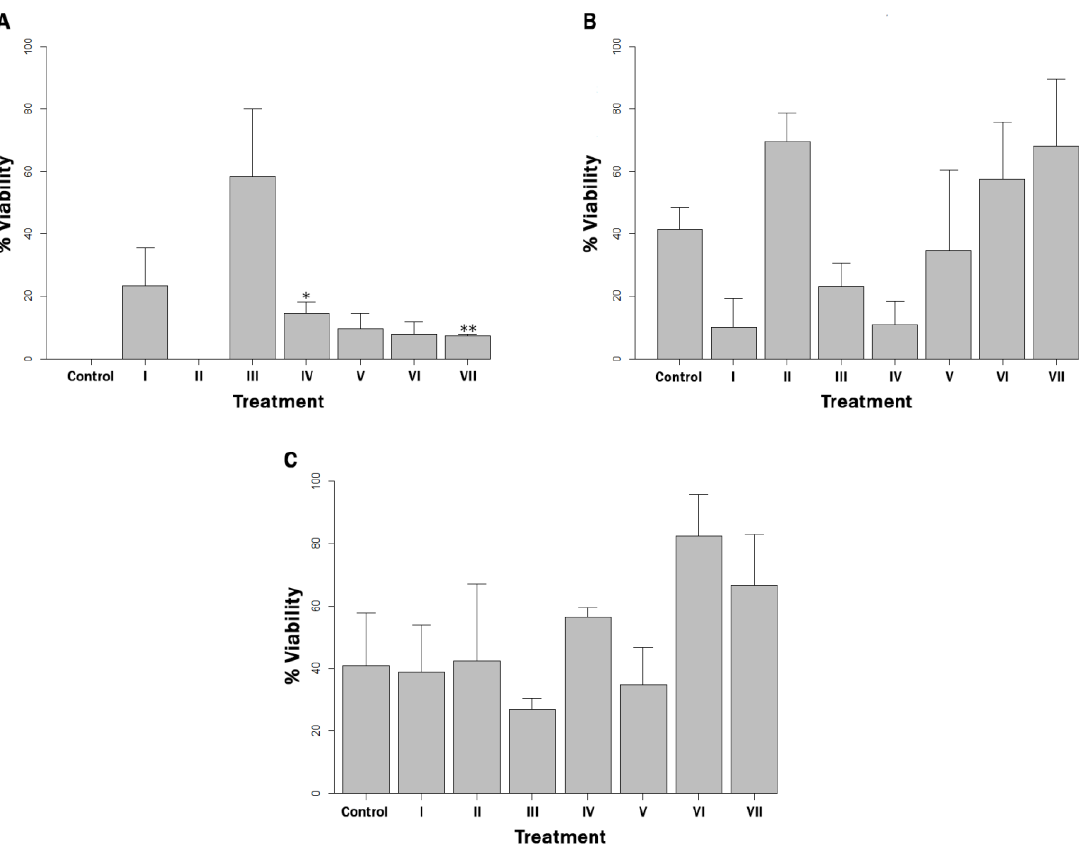
Figure 2. Percentage of protection of viable cells (% Viability) in milk artificially contaminated with: ( A ) 10 2 MAP cells mL −1 , ( B ) 10 4 MAP cells mL −1 and ( C ) 10 6 MAP cells mL −1 , and supplemented with (I) EDTA, (II) BCS, (III) EDTA + BCS, (IV) D-mannitol, (V) gallic acid, (VI) quercetin and (VII) D-mannitol + gallic acid + quercetin, after being challenged with copper ions for 30 min. The determination was made by PhMS-qPCR. p < 0.05 and p < 0.01 are represented by * and **, respectively.